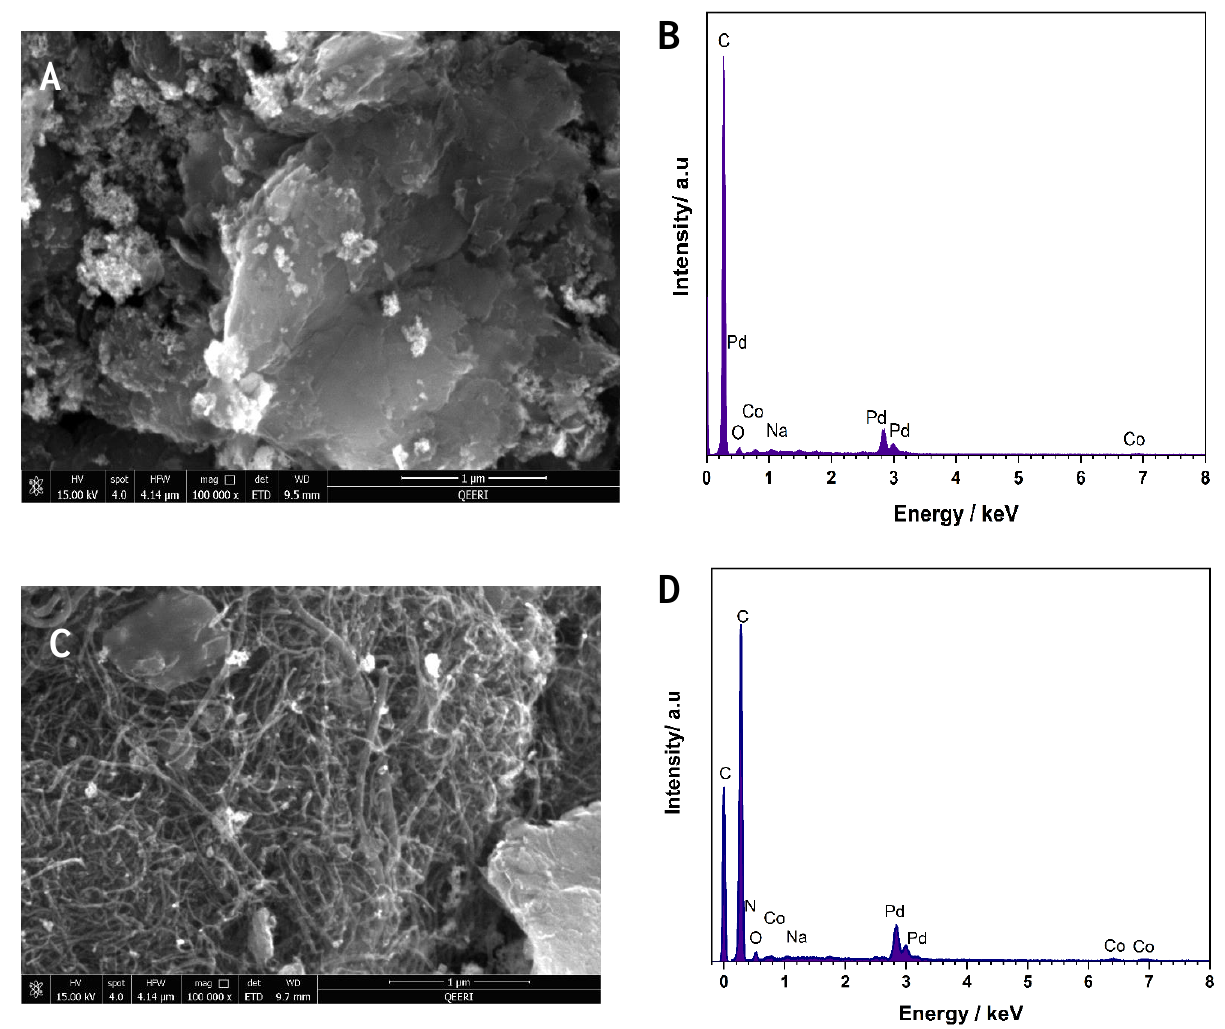
Figure 3. Scanning electron microscopy image and energy-dispersive X-ray spectra for ( A , B ) Pd 1 Co 1 /N-rGO and ( C , D ) Pd 1 Co 1 /CNT.